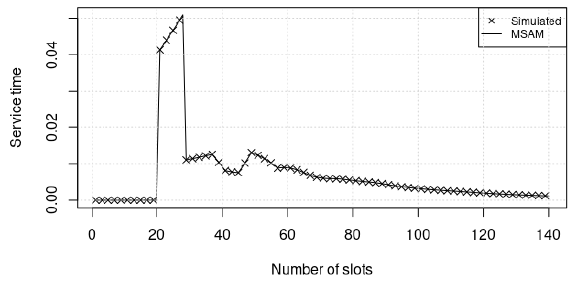
Figure 4. Some of the probability mass functions of the first assessment, ( a ) the inter-arrival distribution of the first node ( b ) the inter-arrival distribution of the second node, ( c ) the inter-arrival distribution of the third node, ( d ) the service time distributions of the three nodes in the 0th back-off stage, ( e ) the service time distributions of the three nodes in the 1st back-off stage, ( f ) the service time distributions of the three nodes in the 2nd back-off stage, ( g ) the service time distributions of the three nodes in the 3rd back-off stage, ( h ) the service time distributions of the three nodes in the 4th back-off stage, ( i ) the service time distributions of the first node, ( j ) the service time distributions of the second node, ( k ) the service time distributions of the third node.